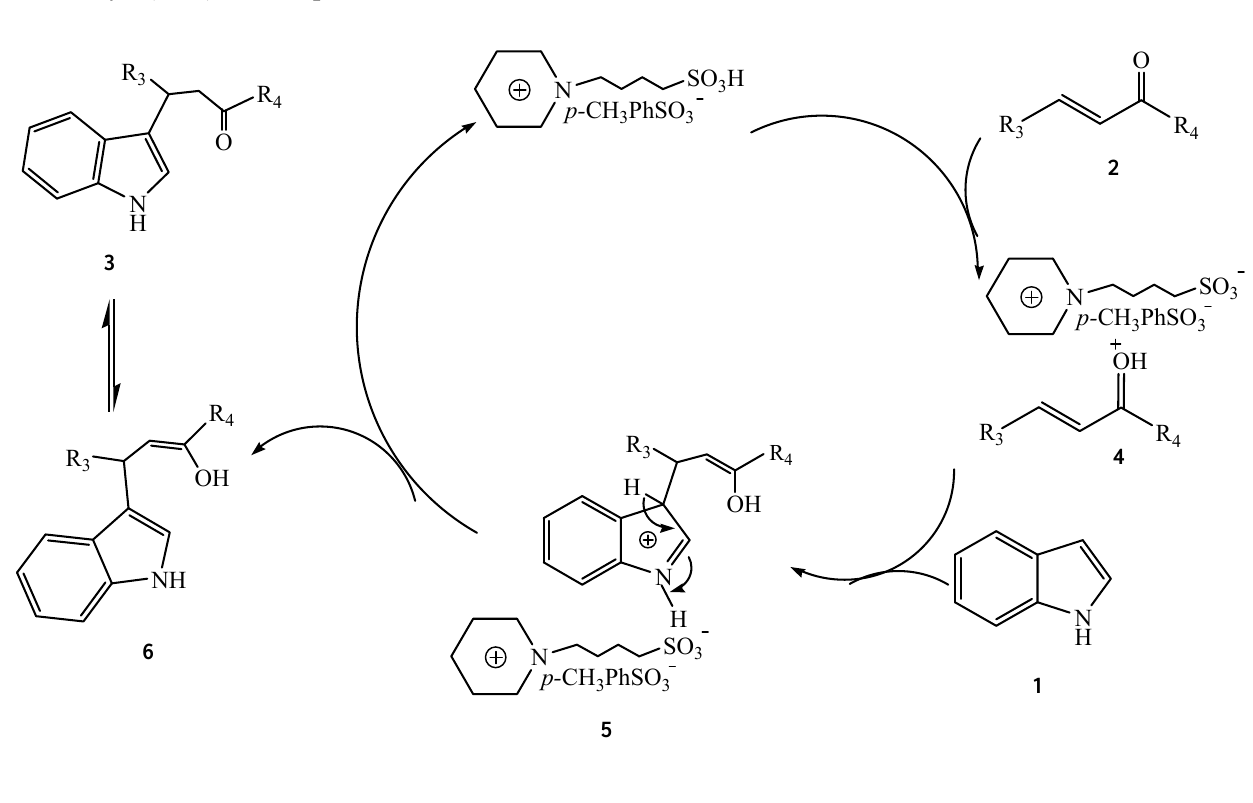
PhSO ]-catalyzed synthesis of β -indolylketones. 3 3